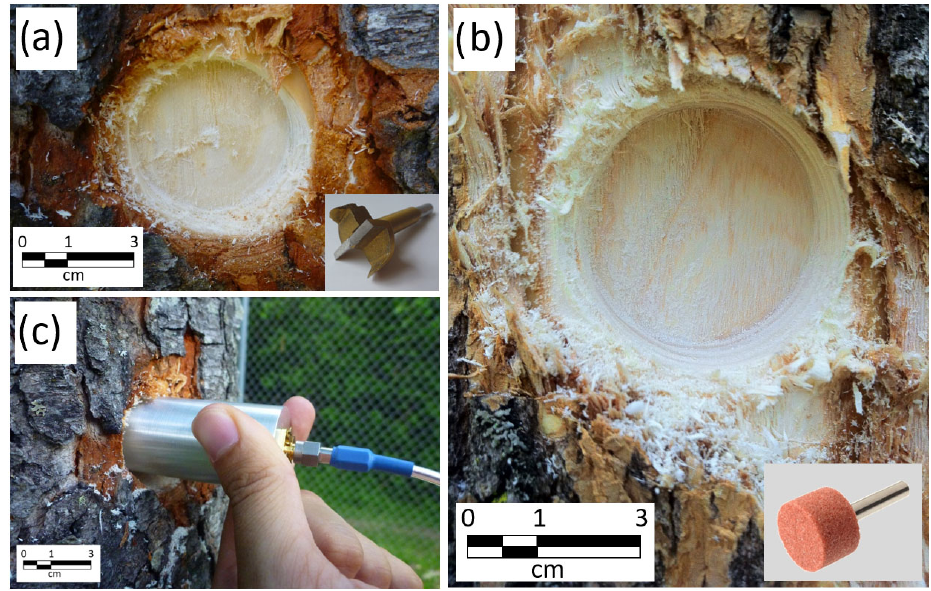
Figure 3. Tangential cut of a black cherry trunk for permittivity measurement. (a) First, a hole is drilled in the trunk using a modified Forstner drill bit. (b) The surface is then flattened using a soft rotary tool. (c) Black cherry trunk permittivity measurement using the OECP. A scale is provided for the images, but not for the